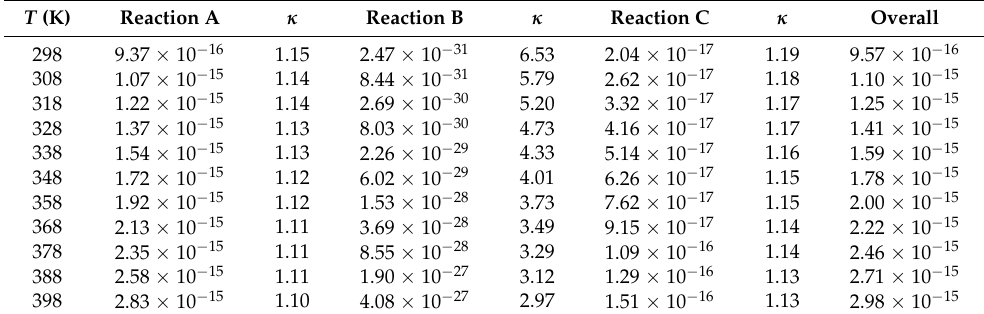
Table 1. Partial and overall rate constants (cm 3 molecule − 1 s − 1 ) and Eckart coefficients as a function of temperature of EB-Ortho reaction with O 2 .